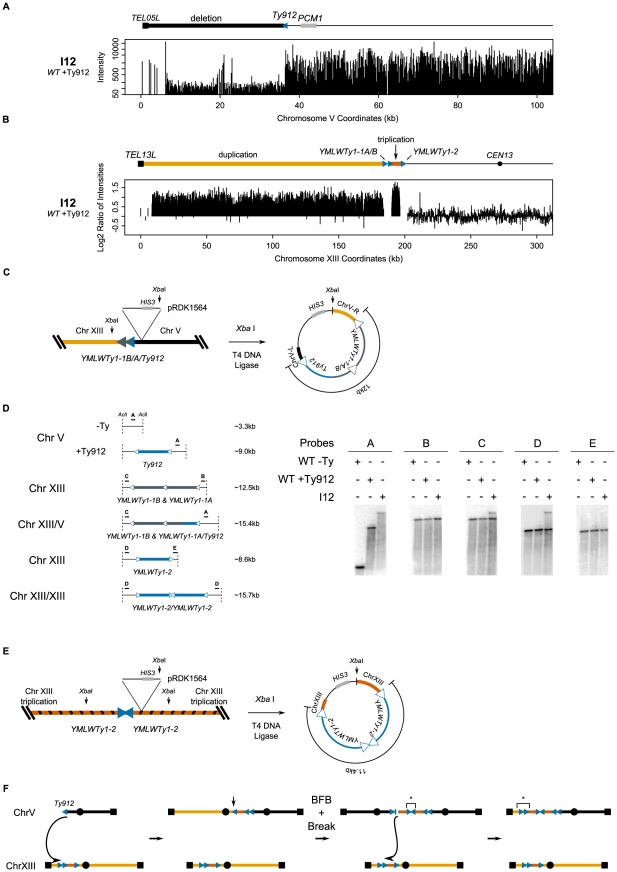
I12's tripartite recombination involves breakage-fusion-bridge.A. Deletion of the region between TEL05L and Ty912 in isolate I12. B. Duplication of the region between TEL13L and YMLWTy1-1A/B. Triplication of the region between YMLWTy1-1A/B and YMLWTy1-2. C. Schematic of the integration of pRDK1564 near the fusion junction on chromosome V and subsequent steps utilized to create a vector cloning the fusion junction. The Ty fusion vector measures approximately 12 kb, as would be expected if Ty912 recombined with YMLWTy1-1A. D. Map of Southern probes and sizes of the expected fragments. DNA from the wild-type −Ty (WT −Ty), wild-type +Ty912 (WT +Ty912), and I12 were cut with restriction enzyme Acl I and subsequently probed with the indicated Southern probes. Bands within a dotted box represent equivalently sized bands. E. Schematic of the integration of pRDK1564 near a copy of YMLWTy1-2 and subsequent steps utilized to create a vector cloning the fusion junction. Results indicated two copies of the triplicated region fused together in an inverted fashion with the Ty fusion measuring approximately 11.4 kb, as would be expected if YMLWTy1-2 underwent a break-fusion-bridge cycle. F. Exposed Ty912 DNA invades YMLWTy1-1A on chromosome XIII. This leads to the formation of a dicentric that then leads to a breakage fusion bridge event at the vertical arrow followed by another break; the broken chromosome is repaired by mediating a translocation to homologous DNA on the wild type chromosome XIII. * indicates verified junctions.